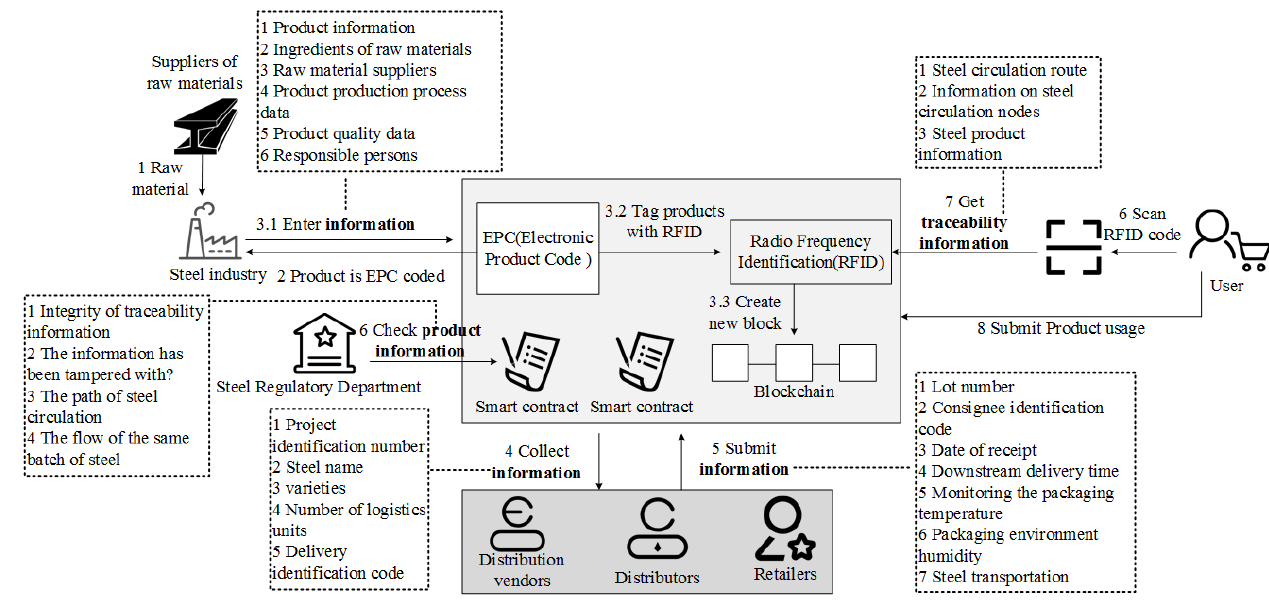
Figure 4. Reconstruction diagram of reference [25].